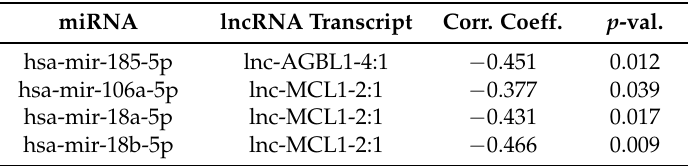
Table 2. lncRNAs highly correlated with miRNAs in